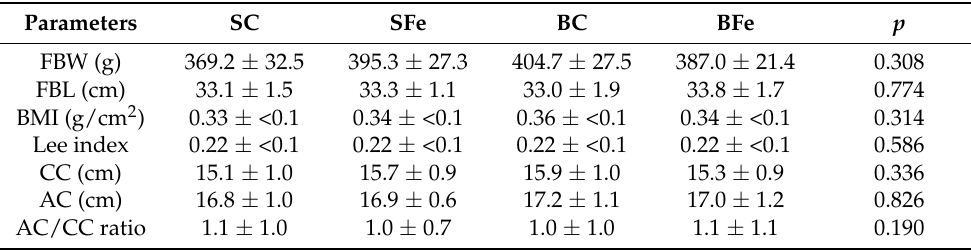
Table 2. Food intake and somatic parameters of rat treated or not with a high dose of FeSO 4 and diets added with either soybean oil or buriti oil.